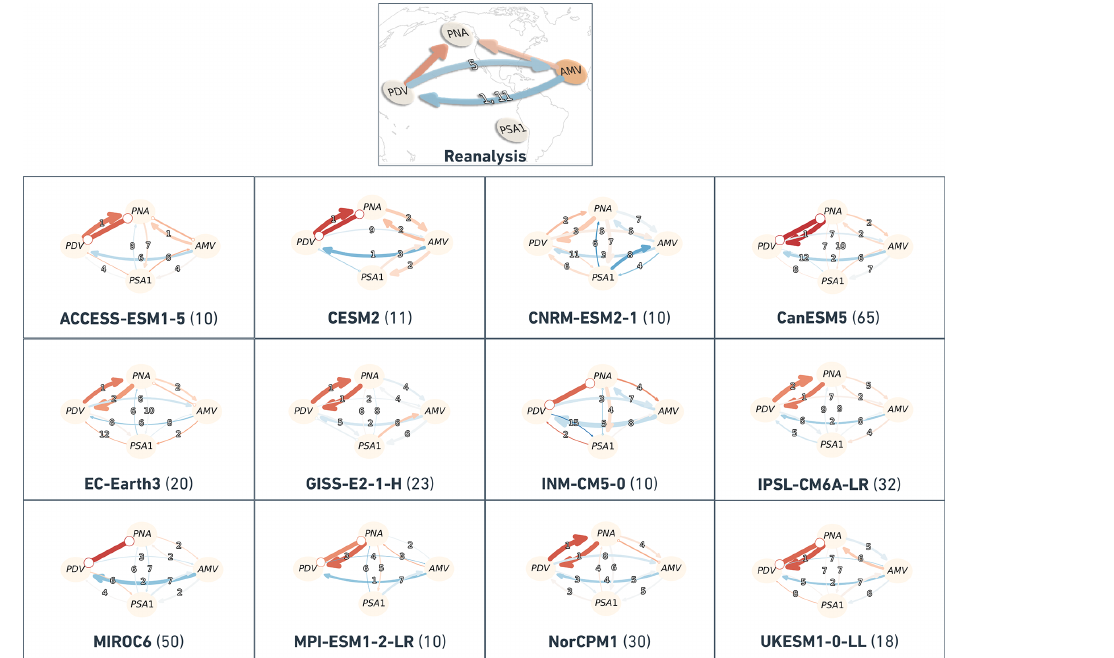
Figure A2. Similar to Fig. 7 but for the 12 CMIP6 models during the out-of-phase regime . Each panel has a label stating the model name and the number of ensemble members between parentheses. The auto-MCI values were not taken into